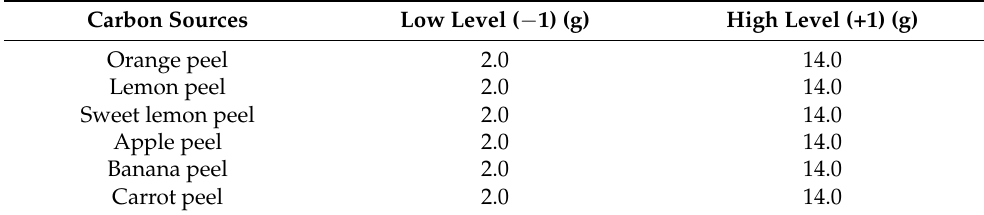
Table 1. The low and high levels of carbon sources used in the PB design.